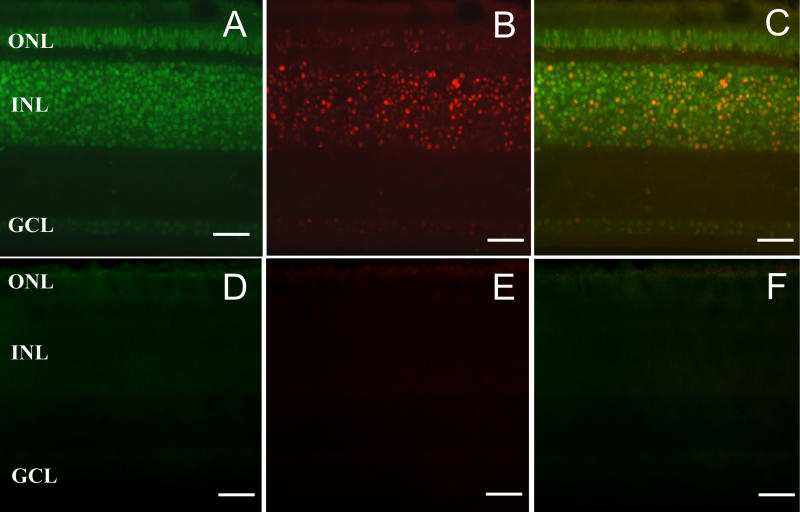
Localisation of
Opn4m and
Opn4x Expression in the Chicken Retina
Dual in situ hybridisation histochemistry using probes for both
cOpn4x (fluorescein) and
cOpn4m (digoxigenin) reveals extensive
cOpn4x expression [green; (A)], a more restricted pattern for
cOpn4m [red; (B)], and widespread colocalisation of mRNA for the two genes [yellow; (C), merged image] in sections from 2-wk-old chicken retina. Control sense probes showed no nonspecific labelling [(D), cOpn4x; panel E, cOpn4m; (F), merged image]. ONL = outer nuclear; INL = inner nuclear layer; GCL = ganglion cell layer. Scale bar = 50 μm.